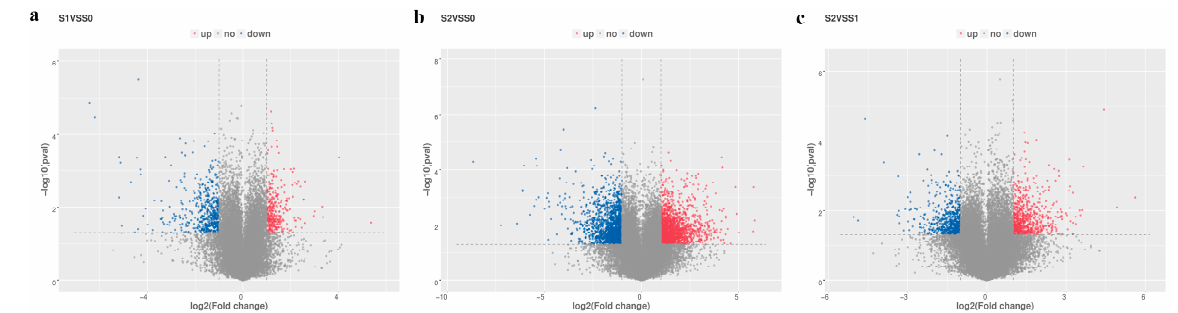
Figure 2. Differentially expressed genes in the pairwise comparisons. ( a ) DEGs in S1 vs. S0; ( b ) DEGs in S2 vs. S0; ( c ) DEGs in S2 vs. S1.